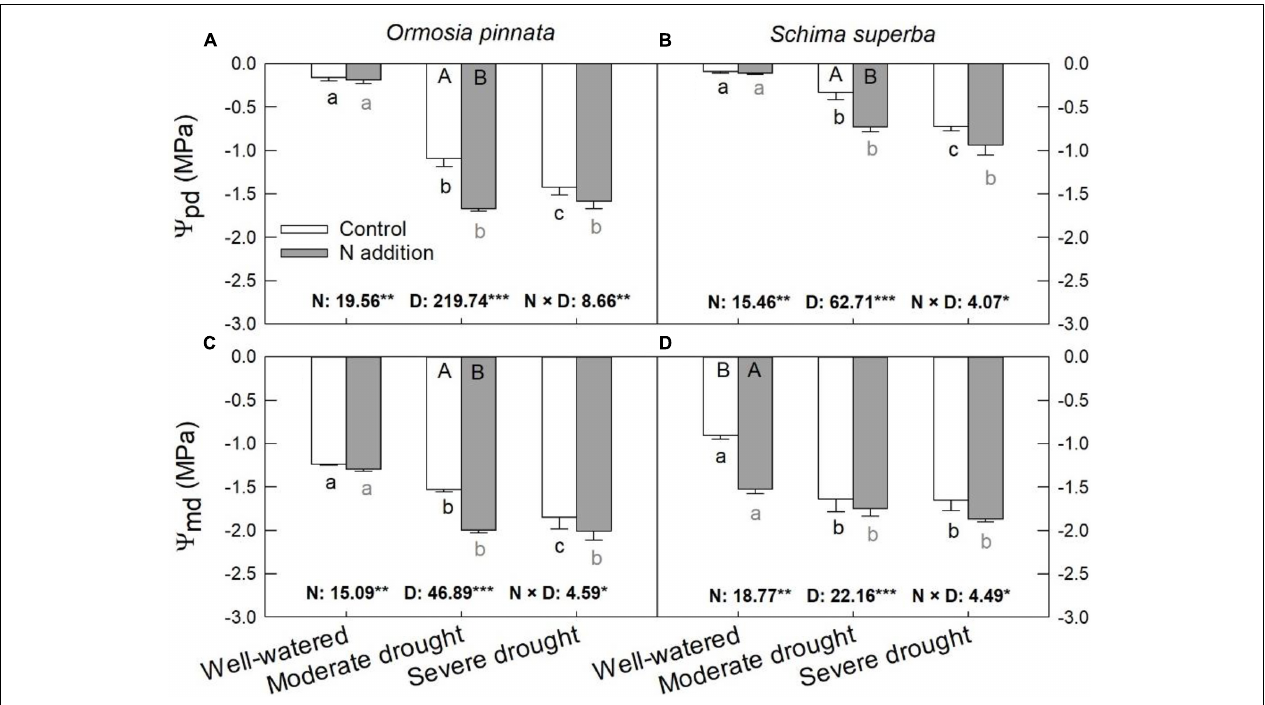
FIGURE 3 | Responses of predawn ( (cid:57) pd , A,B ) and midday ( (cid:57) md , C,D ) leaf water potential of O. pinnata and S. superba to different watering and N addition treatments. Bars show means ± SE ( n = 3). Different lowercase letters above bars indicate significant differences among three watering regimes within each N addition rate. Different capitalized letters below bars indicate significant differences between control and N addition within each watering regime. F -values of the two-way ANOVA of nitrogen (N), drought (D), and their interactions (N × D) are indicated. * P < 0.05; ** P < 0.01; *** P < 0.001; ns, not